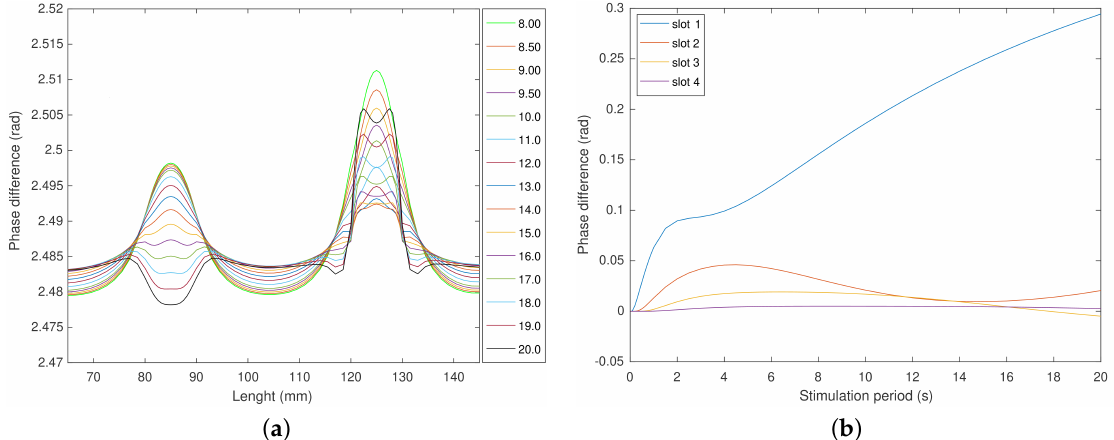
Figure 12. Detailed view of slots 2 and 3 for periods between 8 to 20 s. ( a ) Phase delay of slots 2 and 3 for stimulations ranging from 8 and 20 s. ( b ) Phase difference for periods from 0.02 to 20 s per